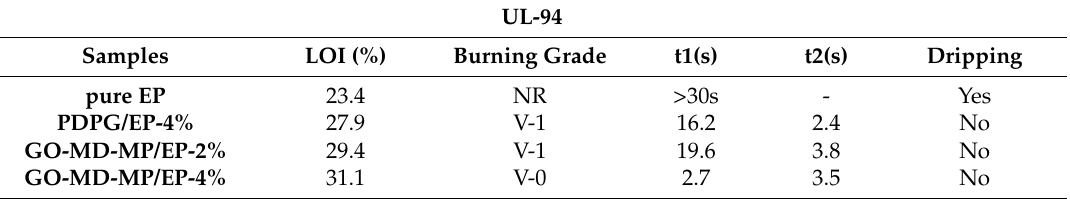
Table 2. Limiting oxygen index (LOI) values and UL-94 data of the cured EP composites.